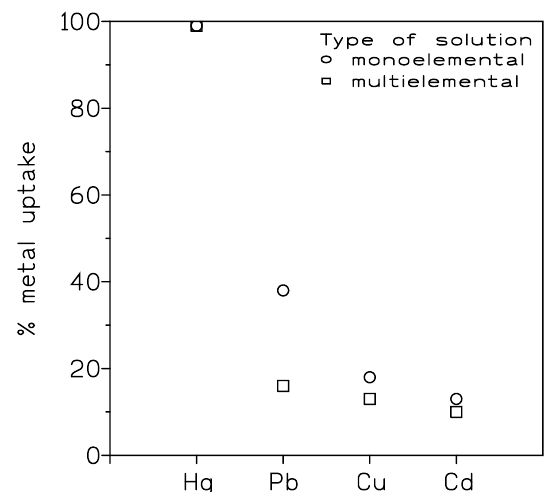
Figure 5. Percentages of metals uptake from monoelemental or multielemental solutions. Adsorbent dosage: 2 g / L. Temperature: 30 ◦ C. Time: 6 h. Aqueous solutions in monoelemental solutions (pH 5.5): Hg(II): 0.80 g / L, Pb(II): 0.92 g / L, Cu(II): 0.98 g / L, or Cd(II): 1 g / L. Aqueous solution in multielemental solution (pH 5.5): Hg(II): 0.32 g / L, Pb(II): 0.37 g / L, Cu(II): 0.39 g / L, and Cd(II): 0.4 g / L.